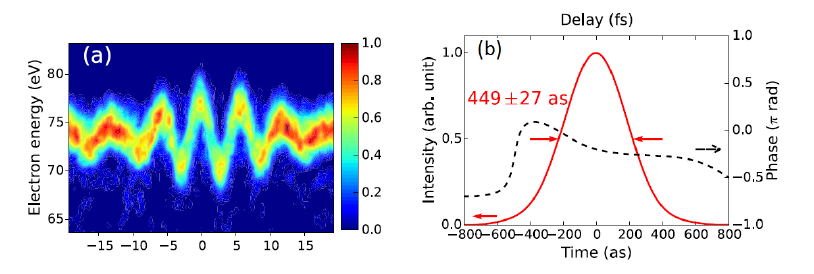
Figure 11. ( a ) Measured streaking spectrograms; ( b ) retrieved temporal profile of the XUV pulse. Adapted with permission from [84], Copyright NPG,